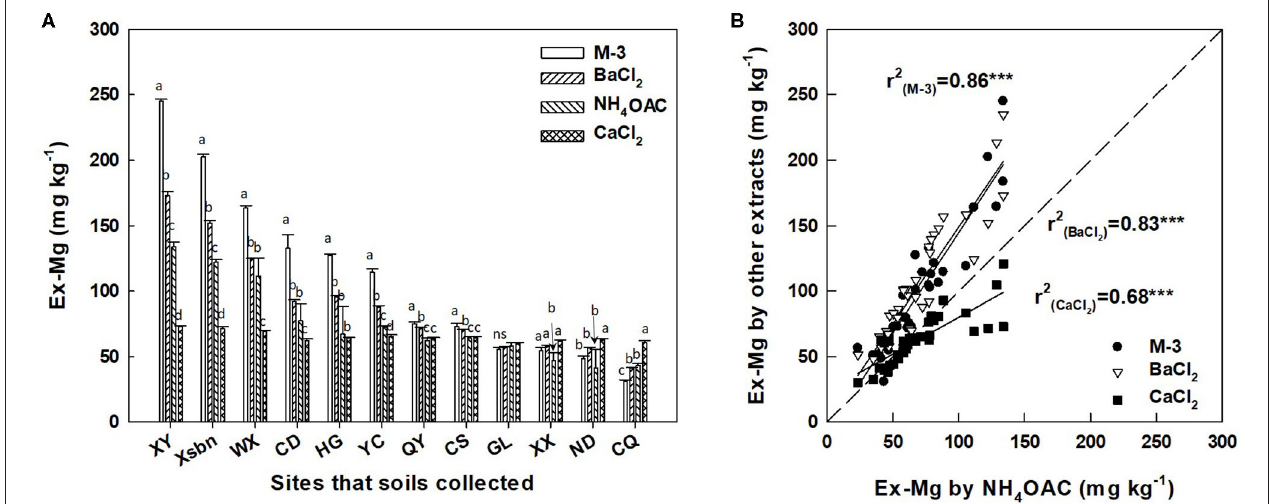
FIGURE 1 | Contents of exchangeable Mg extracted by 1.0mol L − 1 CaCl 2 , 0.01mol L − 1 BaCl 2 , Mehlich-3, and 1.0mol L − 1 NH 4 .OAc in soils pretea cultivation (A) , and the correlation of exchangeable magnesium extracted by different extracts (B) . Different letters above the bar indicate significant ( p < 0.01) differences among different extraction. M-3, Mehlich-3 solution; BaCl 2 , barium chloride; NH 4 OAC, ammonium acetate; CaCl 2 , calcium chloride; Ex-Mg, exchangeable magnesium; XY, Xsbn, WX, CD, HG, YC, QY, CS, GL, XX, ND, and CQ indicated that the soil has been collected in the site of Xinyang, Xishuangbanna, Wuxi, Chengdu, Huanggang,